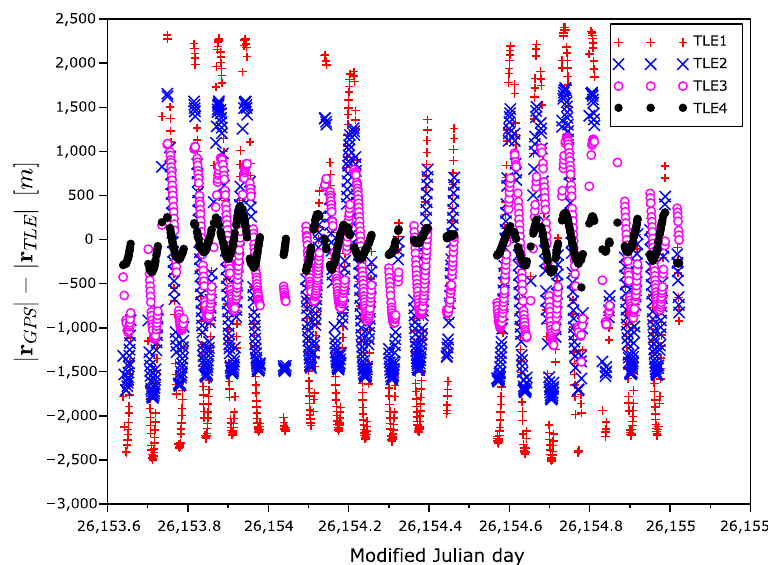
Figure 11. Radius error as a function of time.